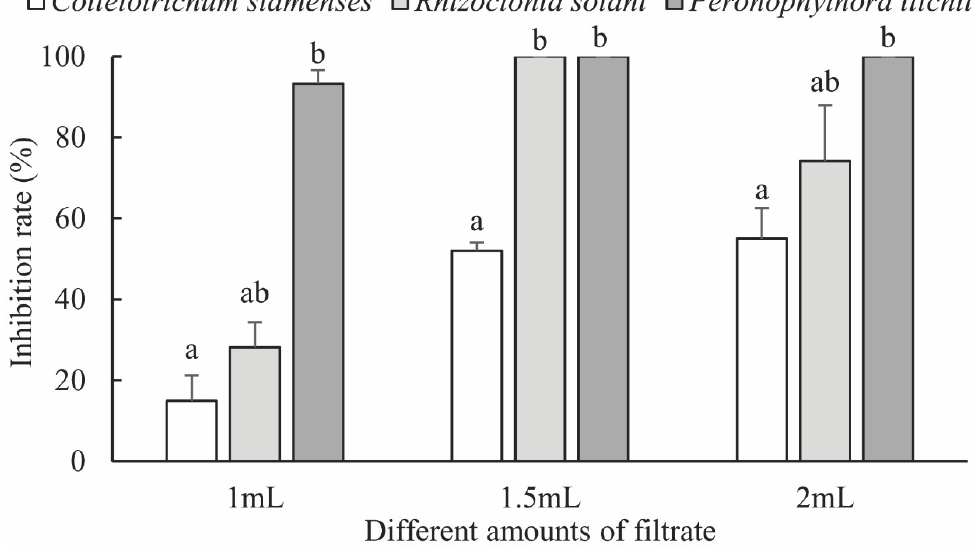
Figure 5. Inhibitory effect of Microbacterium sp. against three plant pathogens with different amounts of filtrate. For each amount of filtrate, bars with the same letter are not significantly different ( p > 0.05, Mann–Whitney U test).